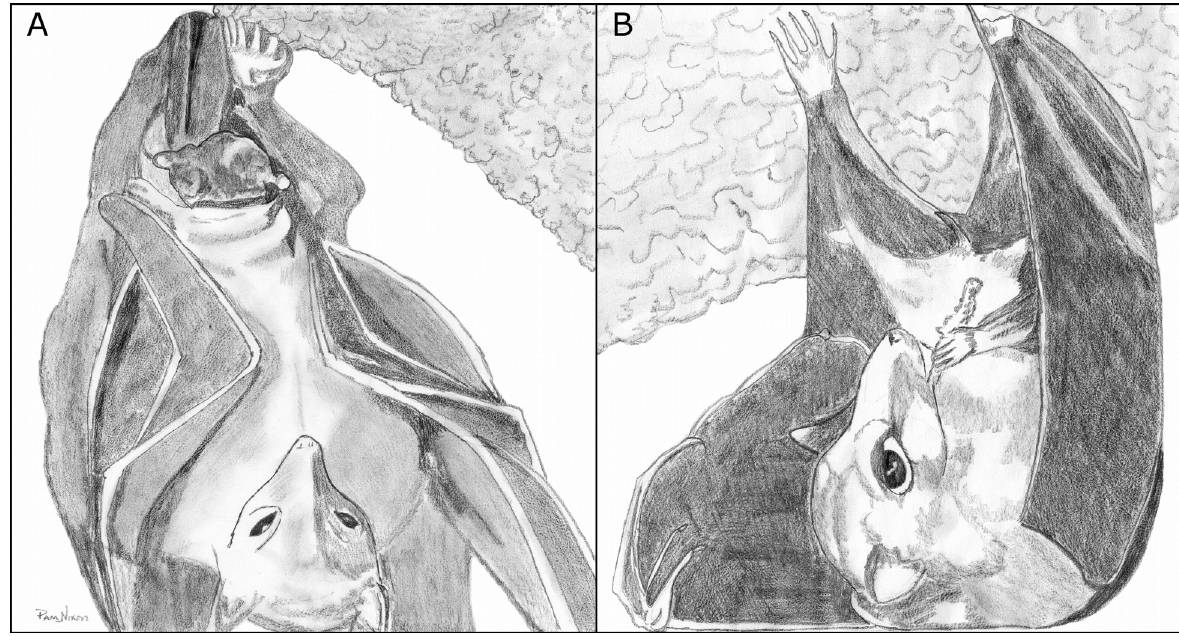
Figure 4. [A] Pregnant female gives birth to a pup that is in breech presentation. The pup’s hindlimbs have emerged from the vagina. The patellas are the features of the pup that are most easily distinguished. [B] Female consumes the placenta after giving birth. The female chews on the placenta, producing a prominent lump in the cheek region of her head. The female uses her right hindfoot to maintain control of the placenta. (Illustration courtesy of Pamela